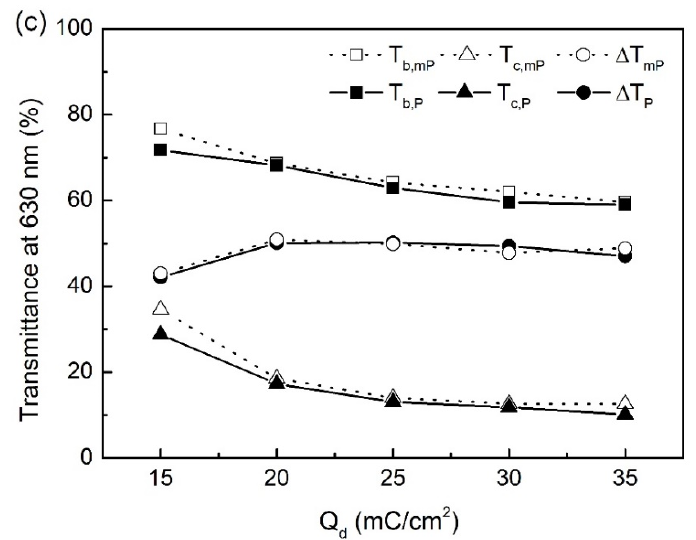
Figure 4. ( a ) Typical transmittance spectra of the PEDOT thin film (Q d = 25 mC/cm 2 ) at different applying potentials. ( b ) Comparisons of the colored-state transmittance spectra of the mPEDOT and PEDOT thin films. ( c ) Comparisons of T c , T b , and ∆ T (at 630 nm) of the mPEDOT and PEDOT thin films. The coloring and bleaching potentials were − 1.1 V (vs. Ag/Ag + ) and 0.3 V (vs. Ag/Ag + ), respectively. The electrolyte was a PC solution containing 0.1 M LiClO 4 and 1.0 mM HClO 4 .